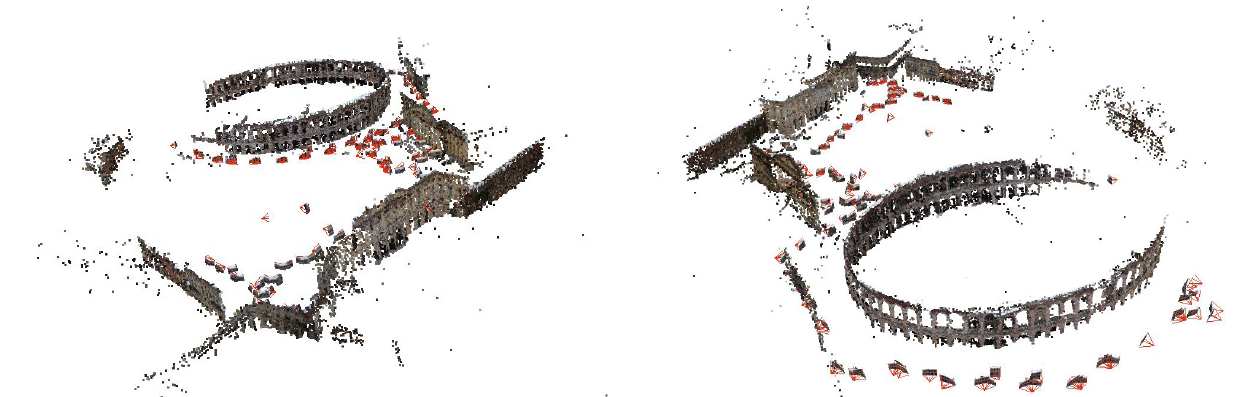
Figure 7: Two views of the reconstruction of “Piazza Bra”